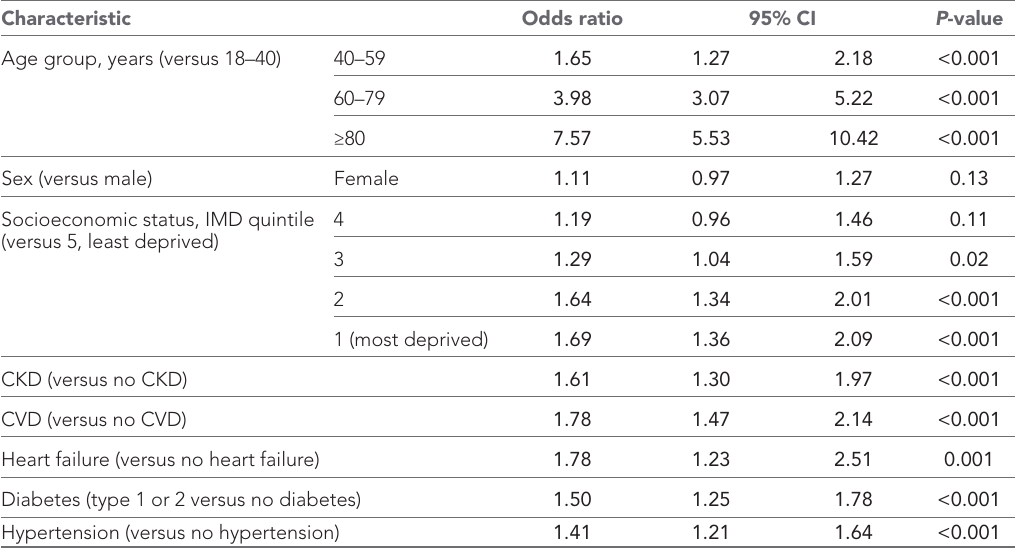
Table 3 Multivariate logistic model on associations between NSAID prescription and AKI within 4 months from the start of prescription period Characteristic Odds ratio 95% CI P - value Age group, years (versus 18–40)